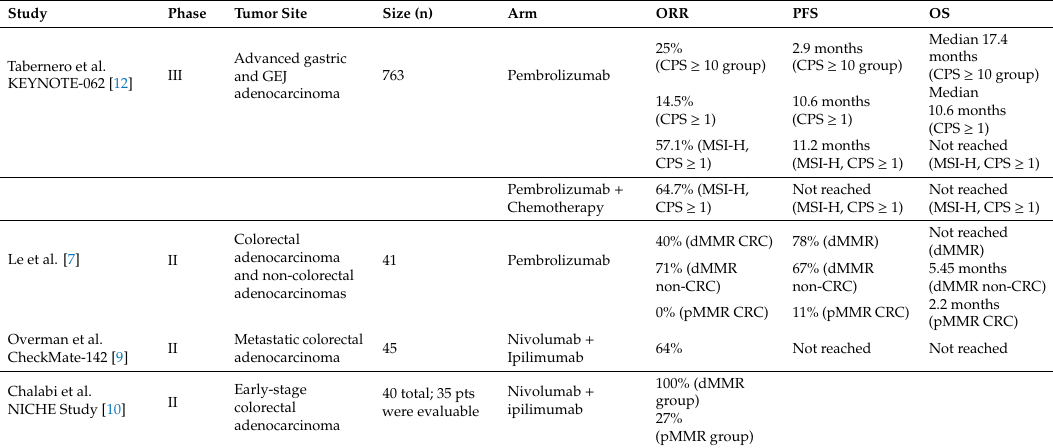
Table 2. Microsatellite instability-high (MSI-H) status and therapeutic